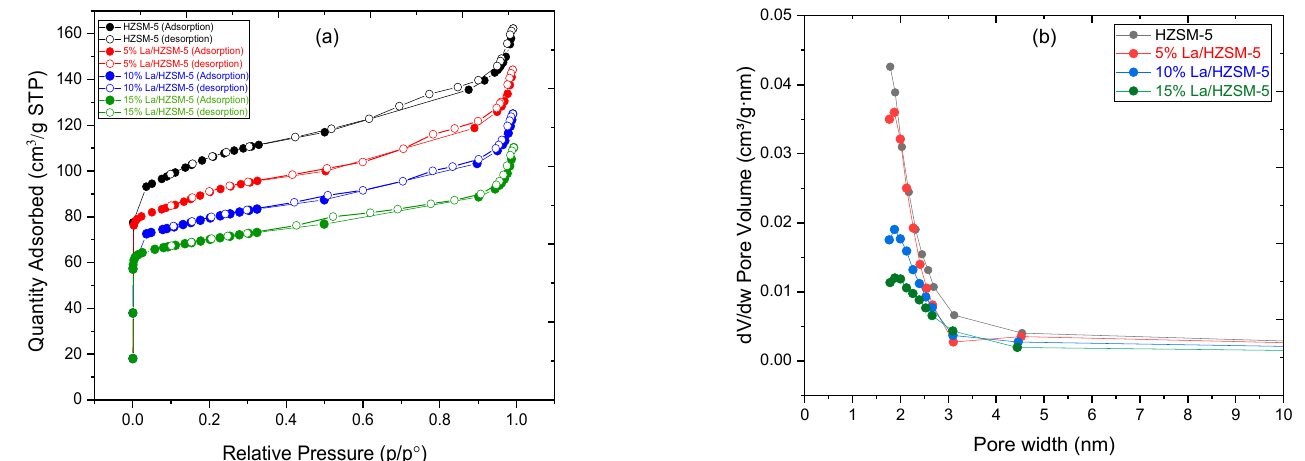
Figure 5. ( a ) N 2 adsorption–desorption isotherms of the parent HZSM-5 and lanthanum-modified HZSM-5 with different loading-weight percentages and ( b ) pore-size distribution of the parent HZSM-5 and lanthanum-modified HZSM-5 with different loading-weight percentages.